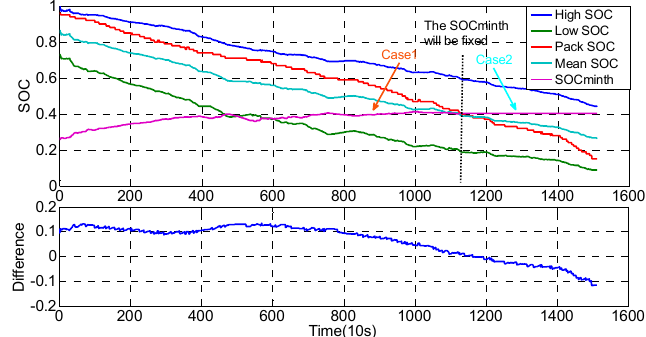
Figure 13. SOC comparison based on different methods.